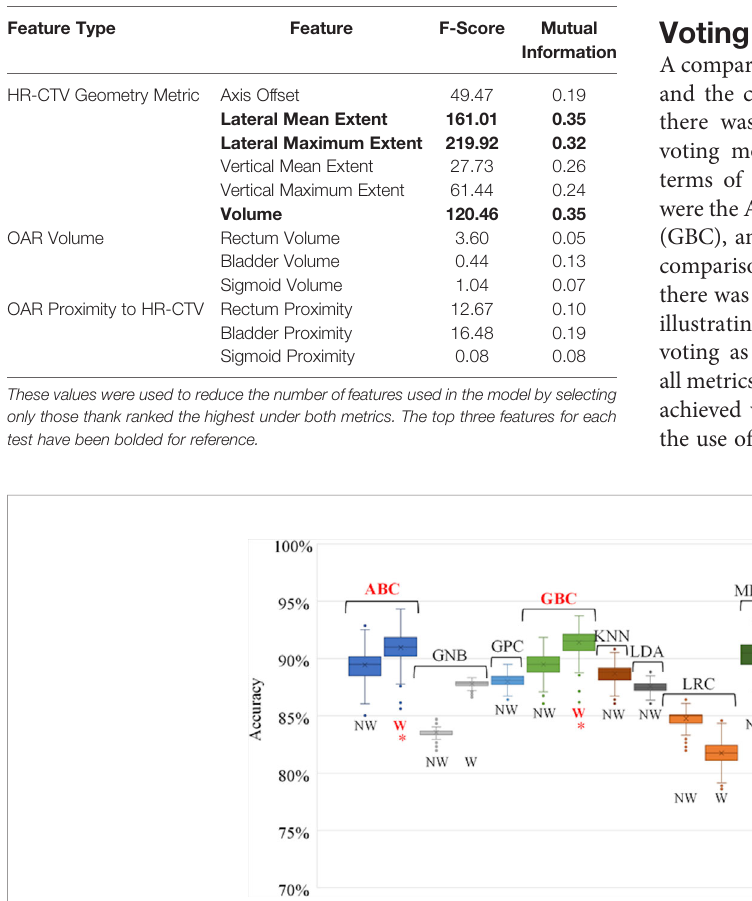
TABLE 3 | ANOVA F-Score and mutual information metrics calculated for each of the extracted geometric features.